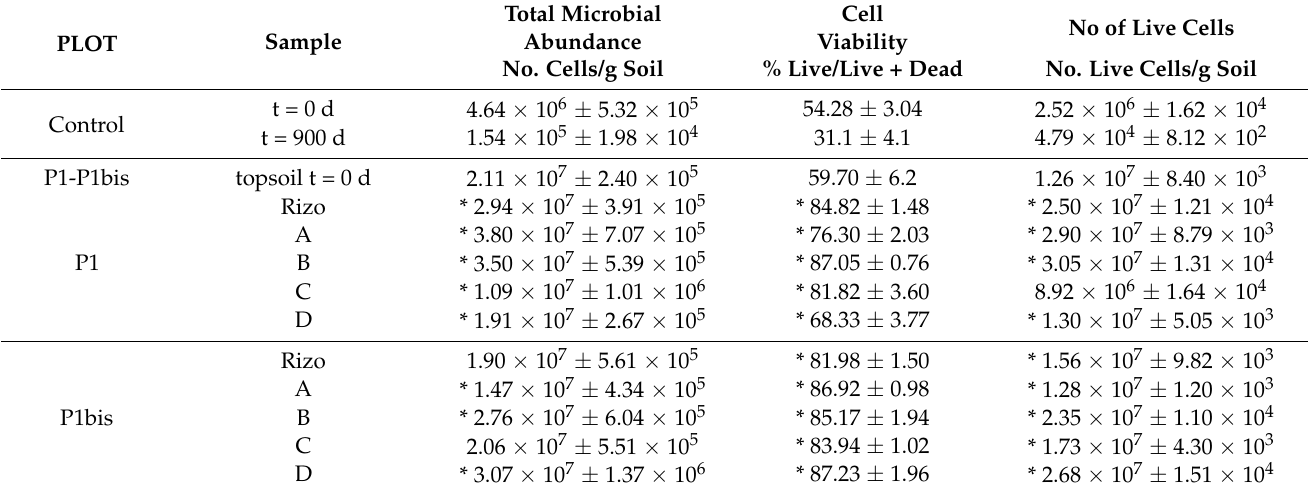
Table 7. Microbial abundance and cell viability of soil samples from the control, P1, and P1 bis plots at different times, ± standard errors (t = 0 and 900 days). Statistical differences ( p < 0.01) are marked with a star. Total Microbial Cell No of Live Cells Abundance Viability PLOT Sample No. Cells/g Soil % Live/Live + Dead No. Live Cells/g Soil t = 0 Control